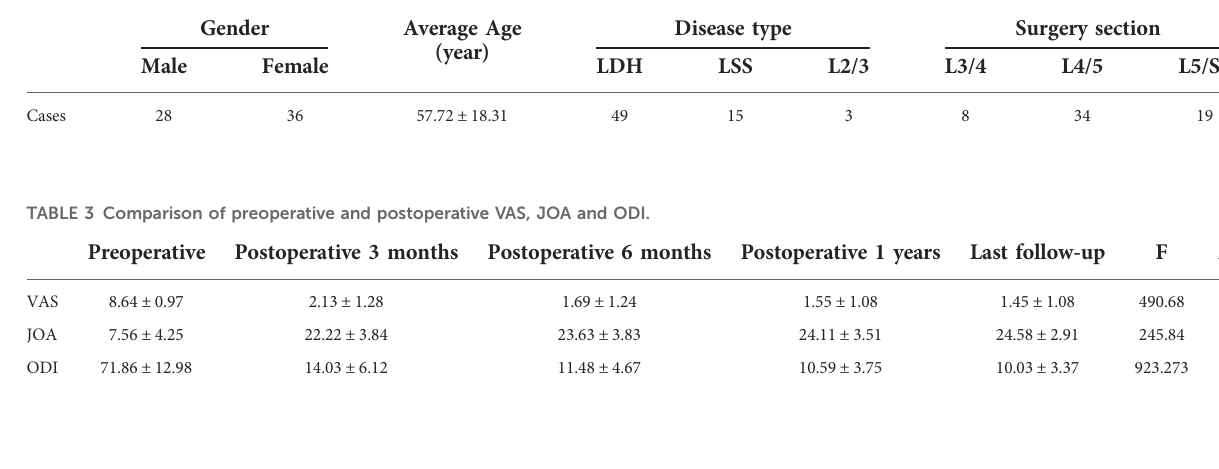
TABLE 2 Baseline demographic data of patients.